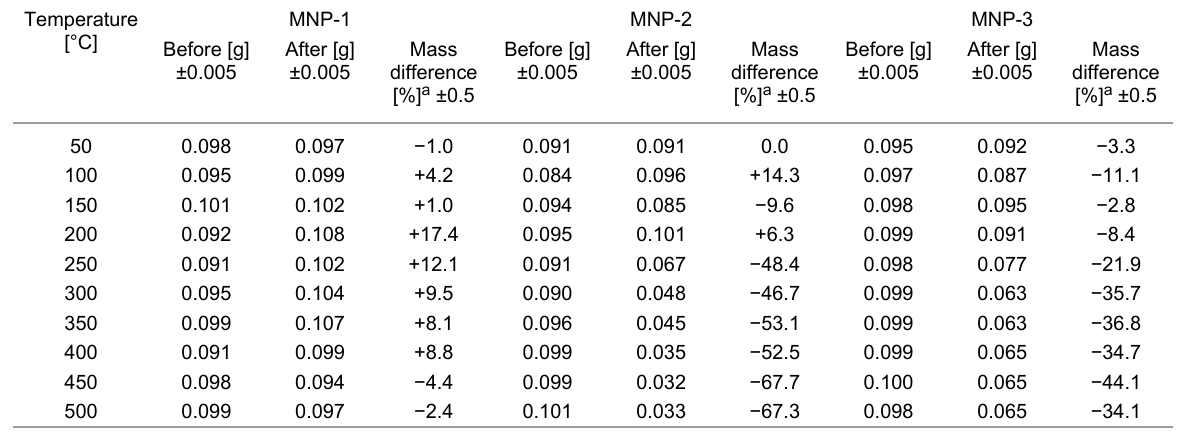
Table 1: Mass change of nanoparticles before and after heat treatment.